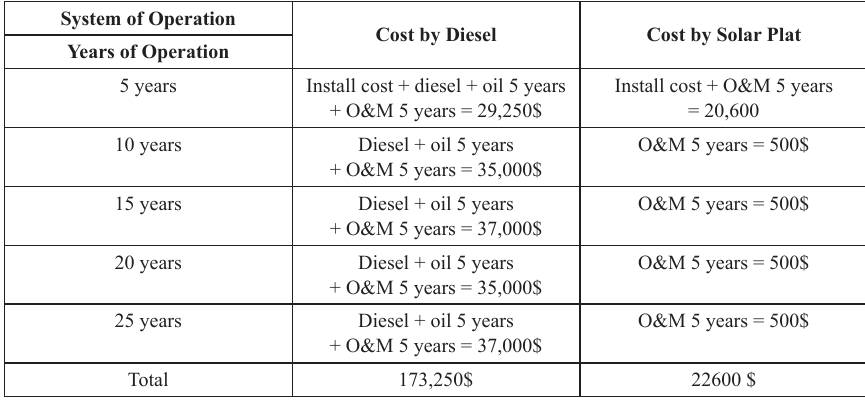
Table 4. Compare between the cost of system